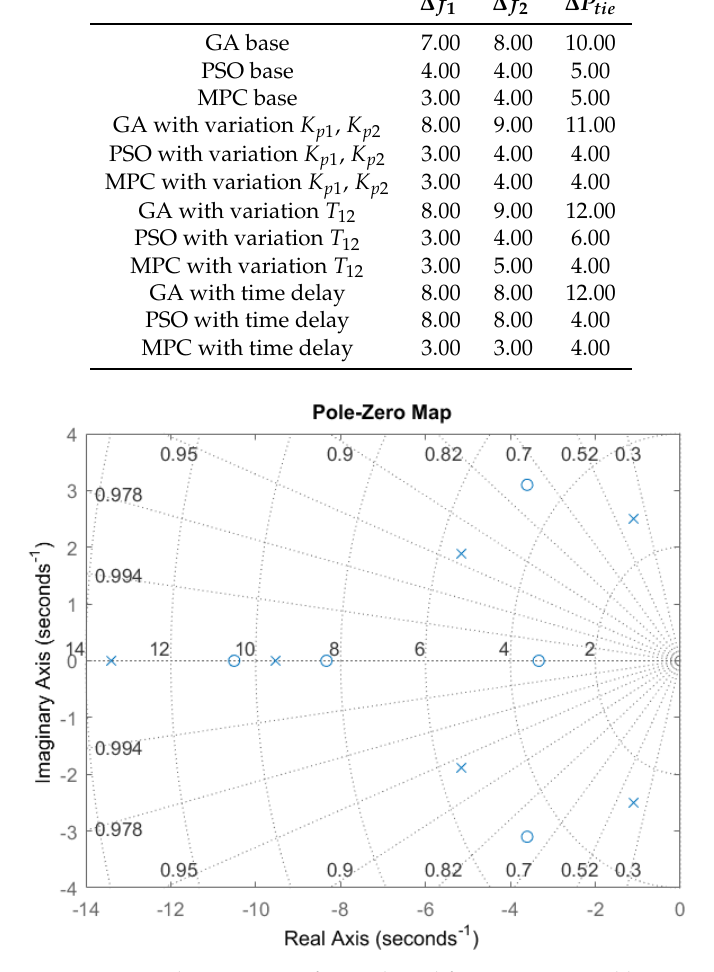
Figure 19. Pole-zero map of MPC-based frequency control loops.